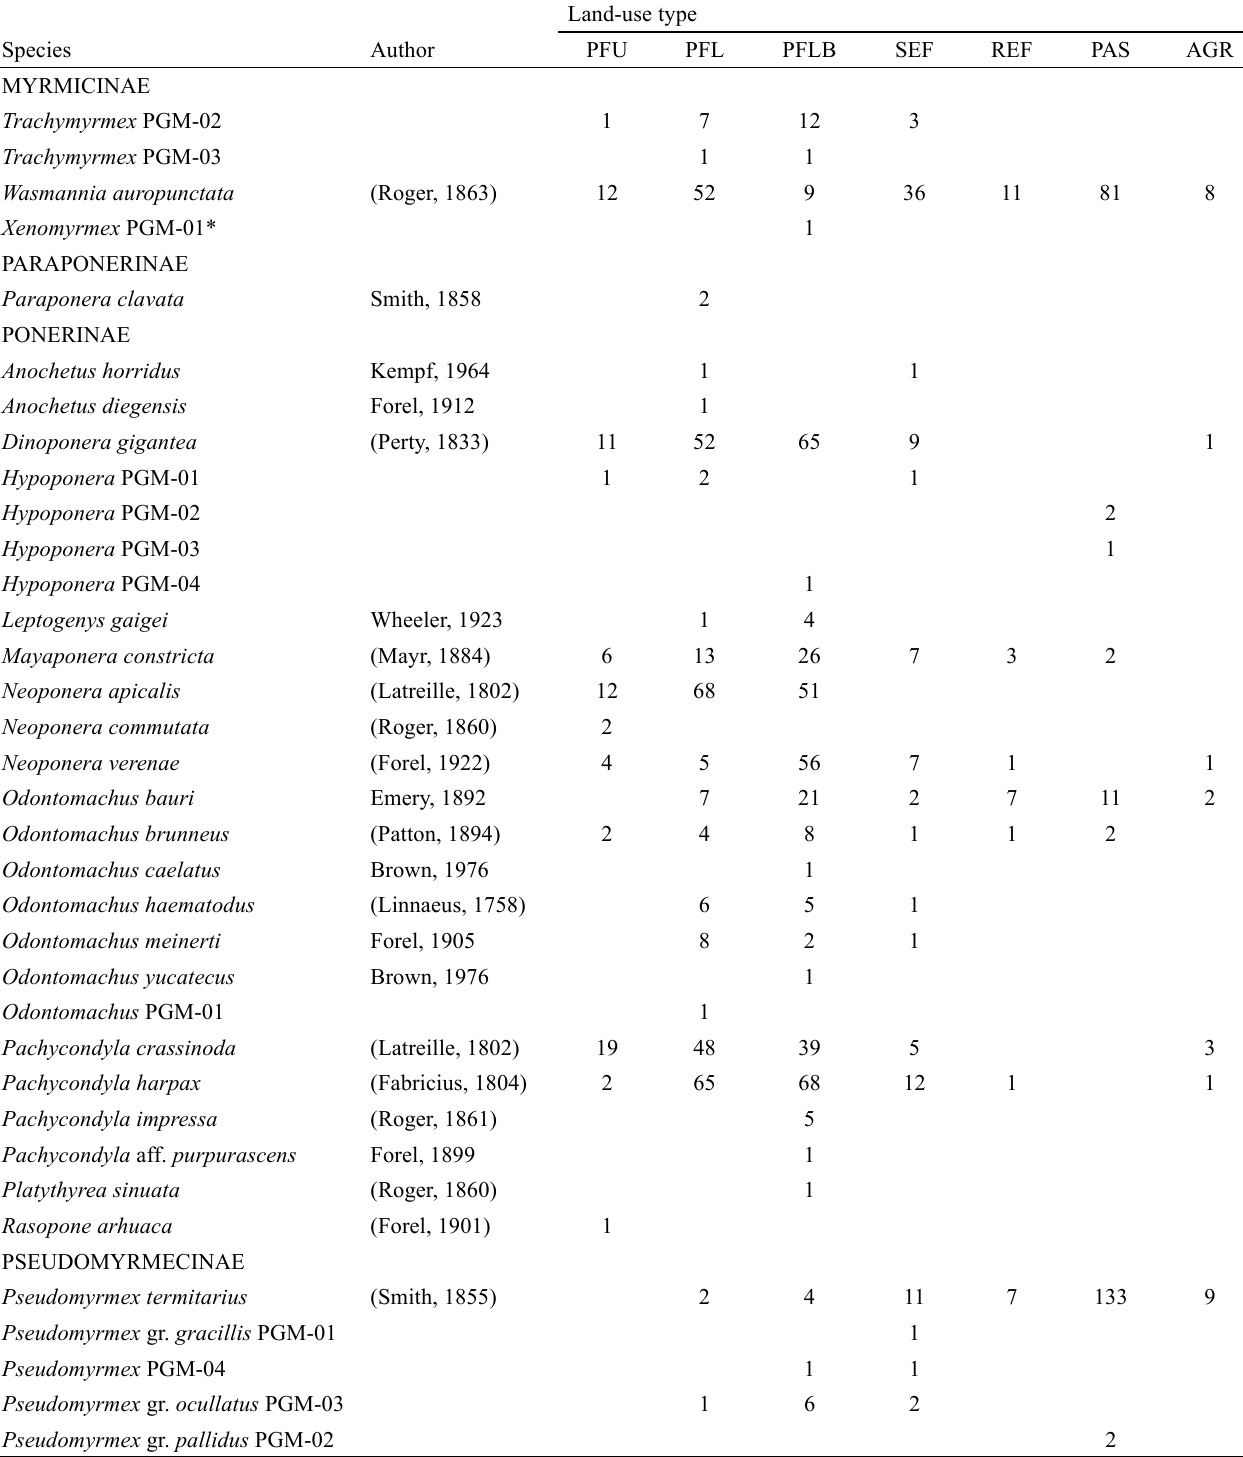
Table 2 . List of ant species collected in this study. Values represent number of records per pitfall traps of each species in each land-use type: PFU – primary forest undisturbed, PFL – primary forest logged, PFLB – primary forest logged and burnt, SEF – secondary forest, REF – reforestation with commercial species, PAS – pasture, AGR – agricultural areas.